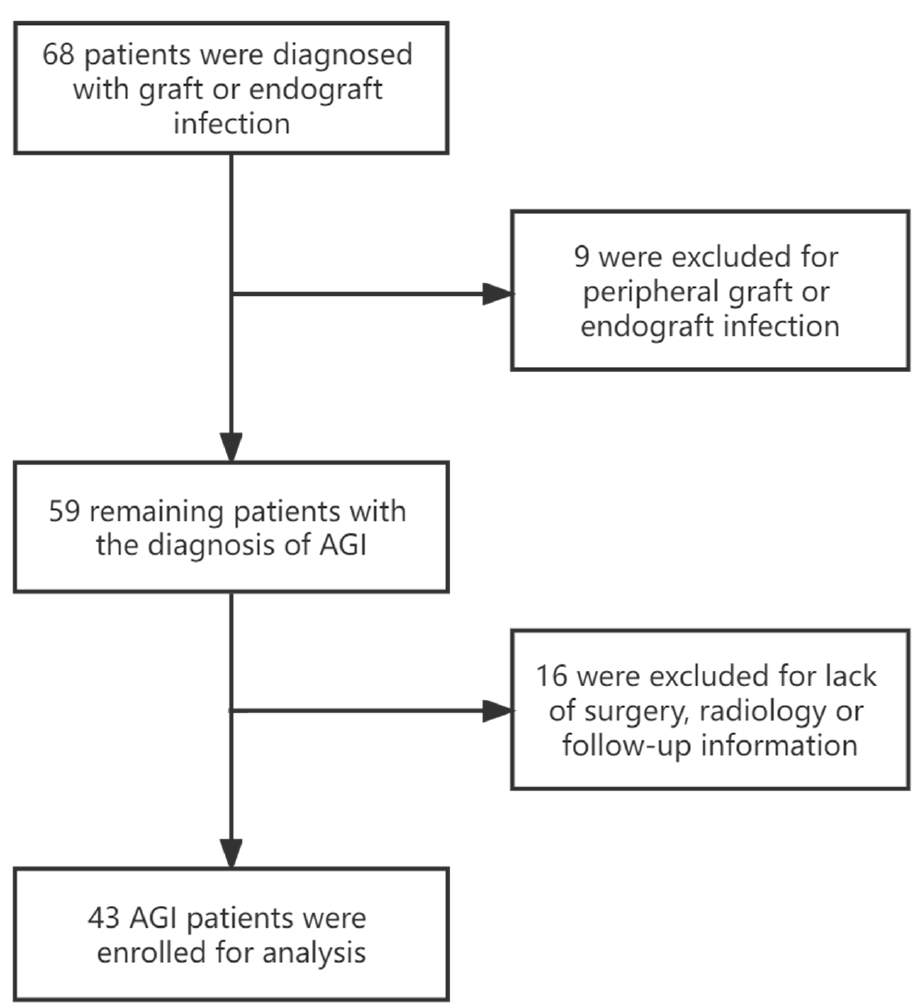
Figure 1. Flowchart of patients enrolled in the study.